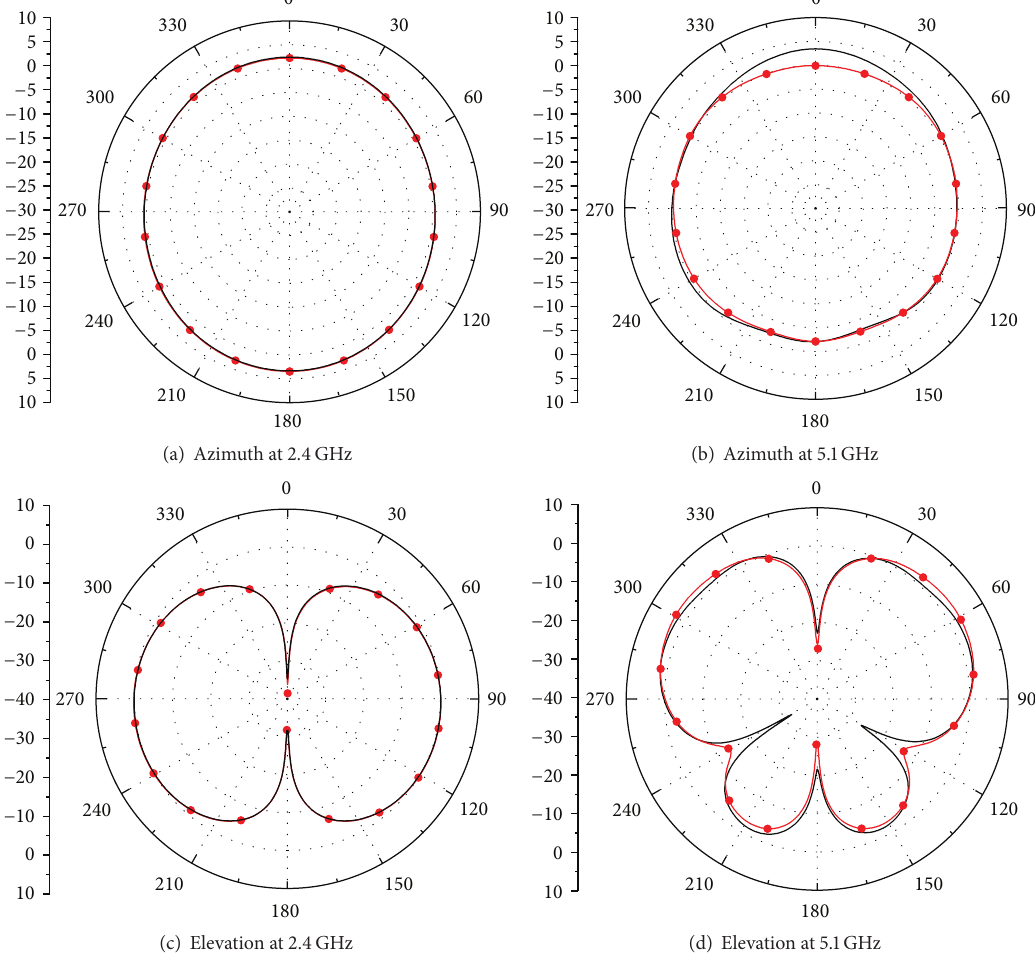
Figure 10: Radiation pattern comparisons: original printed antenna (red curve with circles) and filtenna (black continuous curve).